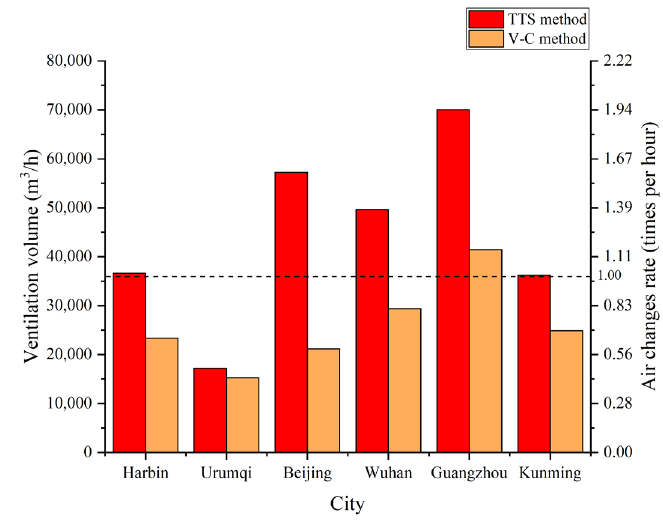
Figure 8. Ventilation volumes and air change